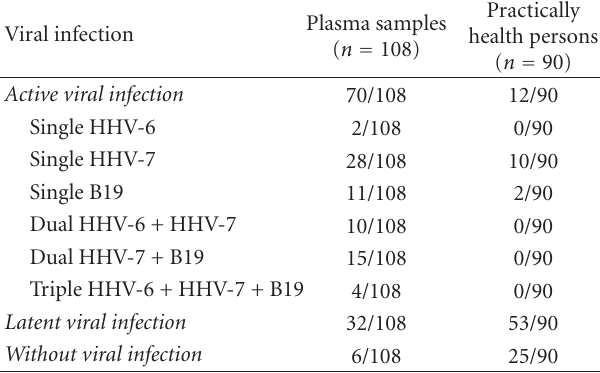
Table 1: Frequency of Active HHV-6, HHV-7 and B19 Infection in ME/CFS Patients and Practically Health